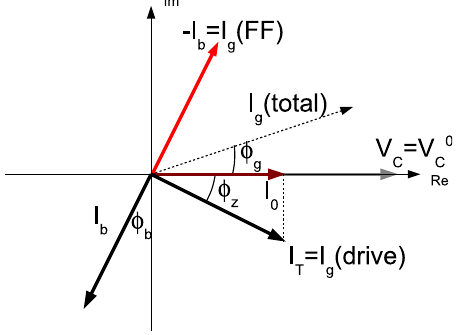
FIG. 17. Phasor diagram with the feedforward compensation.